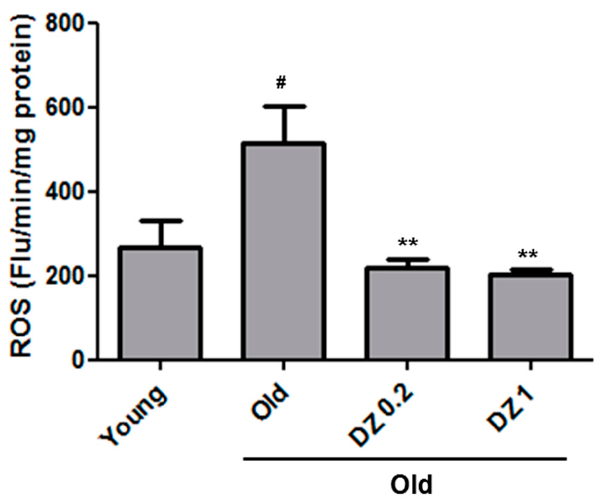
Figure 4. Suppression of ROS level in rat aorta by Dendranthema zawadskii (DZ) extract. ROS level was determined using the DCFDA method in rat aorta homogenate. Each value is the mean ± S.E. of six rats. Young, 5-month-old rats; Old, 15-month-old rats; DZ 0.2, 15-month-old rats treated with DZ extract (0.2 mg/kg/day) for 1 week; DZ 1, 15-month-old rats treated with DZ extract (1 mg/kg/day) for 1 week. Statistical significance: # < 0.05 compared to young. ** < 0.01 compared to old,